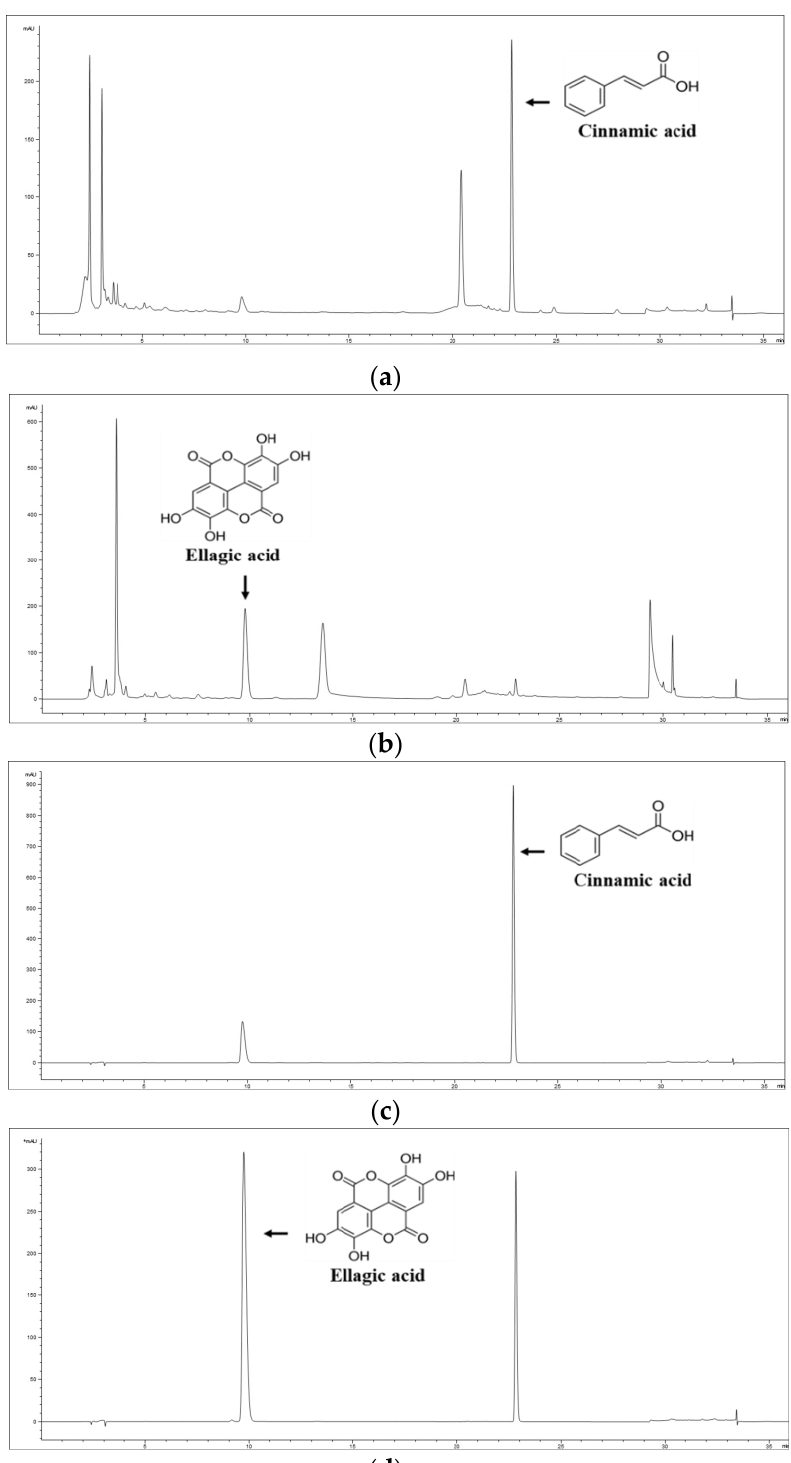
Figure 1. HPLC chromatogram of cinnamic acid (a) and ellagic acid (b) in the HT080 extract; reference standards for cinnamic acid (c) and ellagic acid (d).